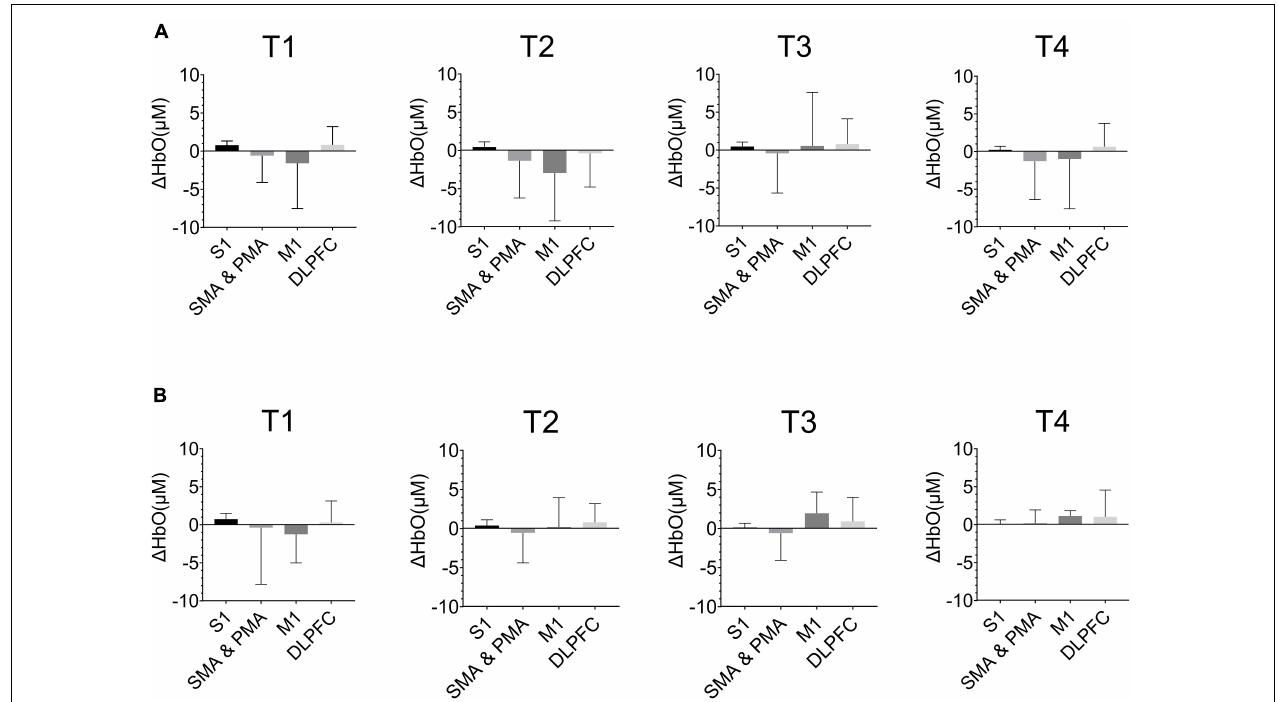
FIGURE 6 | The HbO concentration ( (cid:49) HbO) in the cerebral cortex of regions of interests (ROIs) in T1, T2, T3, and T4. (A) Non-resistance movement; (B) resistance movement. Values were shown with mean + SD.